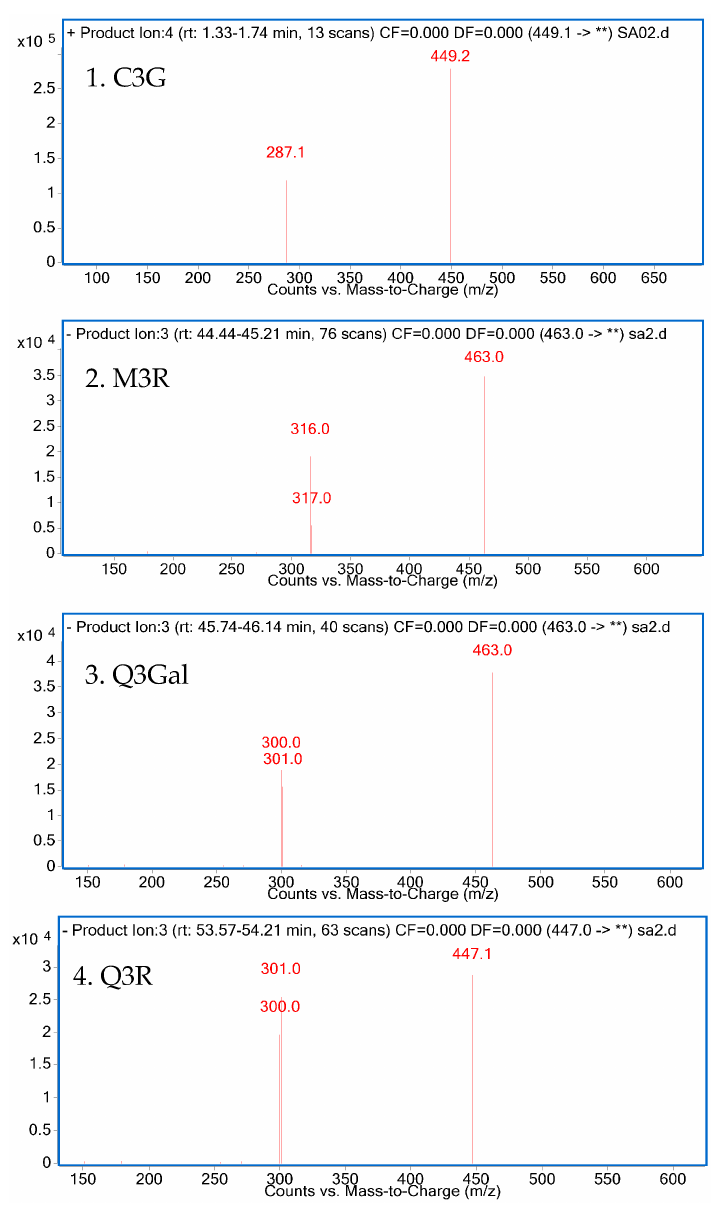
Figure 4. LC-MS 2 spectrum of four purified products.